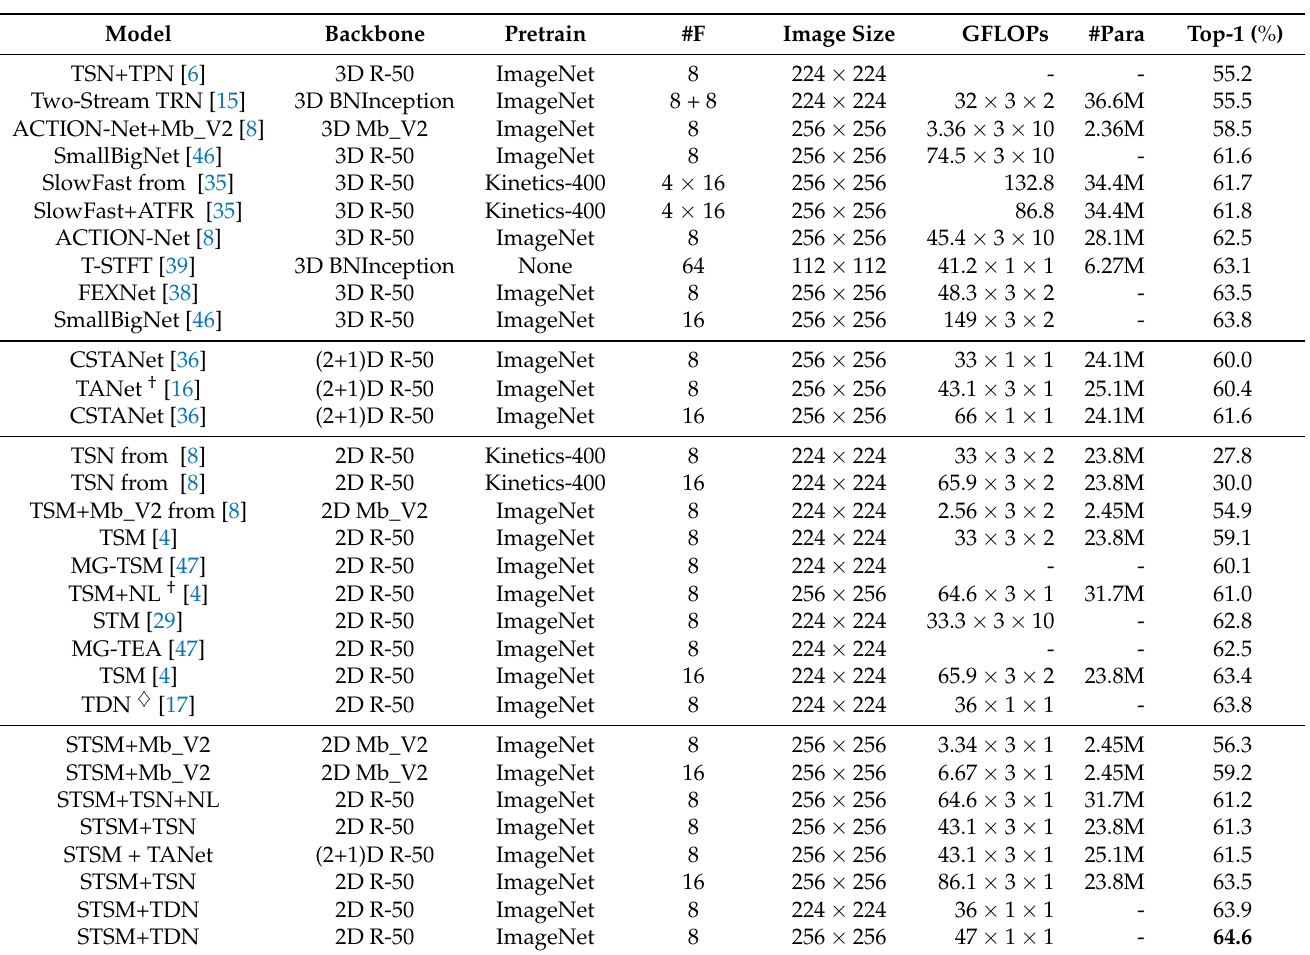
Table 7. The comparison between our method and the state-of-the-art method on the validation set of Something-Something V2. † means that it is the result of our own reproduction. ♦ means the result obtained by directly using the author’s GitHub. The input streams of Two-Stream TRN are RGB and